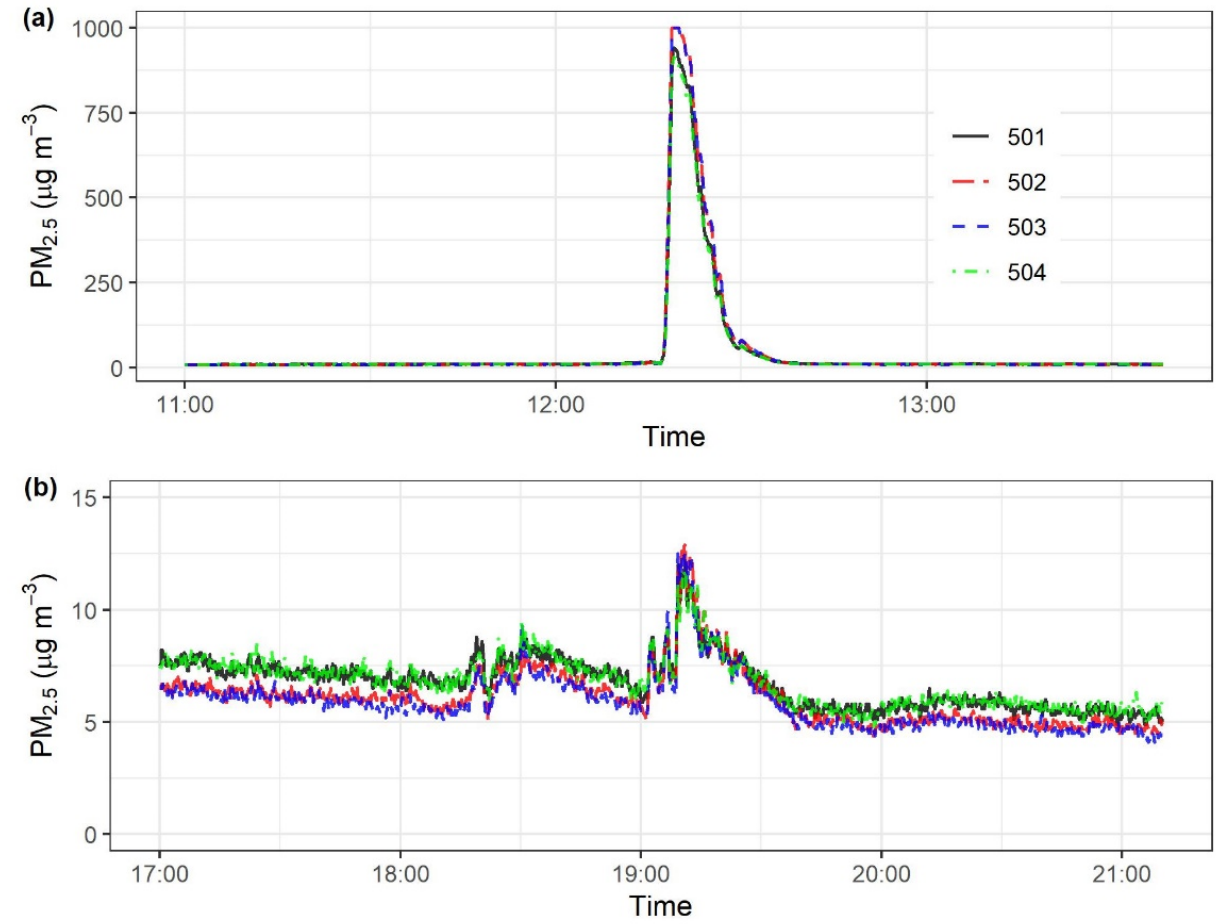
Figure 6. Variations in indoor 1 Hz PM 2.5 concentrations measured by four Smart-P monitors (IDs: 501, 502, 503, and 504) during two simulated cooking events: ( a ) with oil and ( b ) with water.